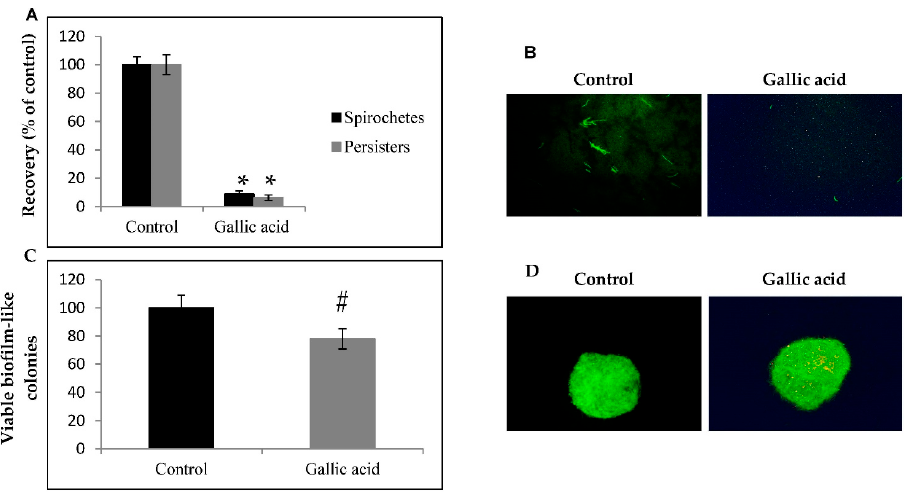
Figure 2. Effect of gallic acid on latent forms of B. burgdorferi . Estimation of repopulated spirochete form of Borrelia burgdorferi ( A ). B. burgdorferi B31 was treated with gallic acid (250 μ g/mL) for 72 h and transferred to fresh tubes containing medium only. After 14 days of subculturing, the presence of typical motile spirochetes was determined by SYBR Green I/PI assay using spectrofluorescent measurement. Representative live/dead images of B. burgdorferi B31 exposed to 250 μ g/mL of gallic acid after 14 days of subculturing ( B ). Images taken at 200× magnification; susceptibility of B. burgdorferi B31 biofilm to gallic acid ( C ). Biofilm like structures were exposed to 250 μ g/mL of gallic acid for 72 h. Viability was assessed by SYBER Green I/IP staining method. Representative live/dead images of B. burgdorferi B31 biofilm exposed to 250 μ g/mL of gallic acid for 72 h. Images taken at 400× magnification ( D ); # p ≤ 0.05, * p ≤ 0.001; control—DMSO only (0.125%).